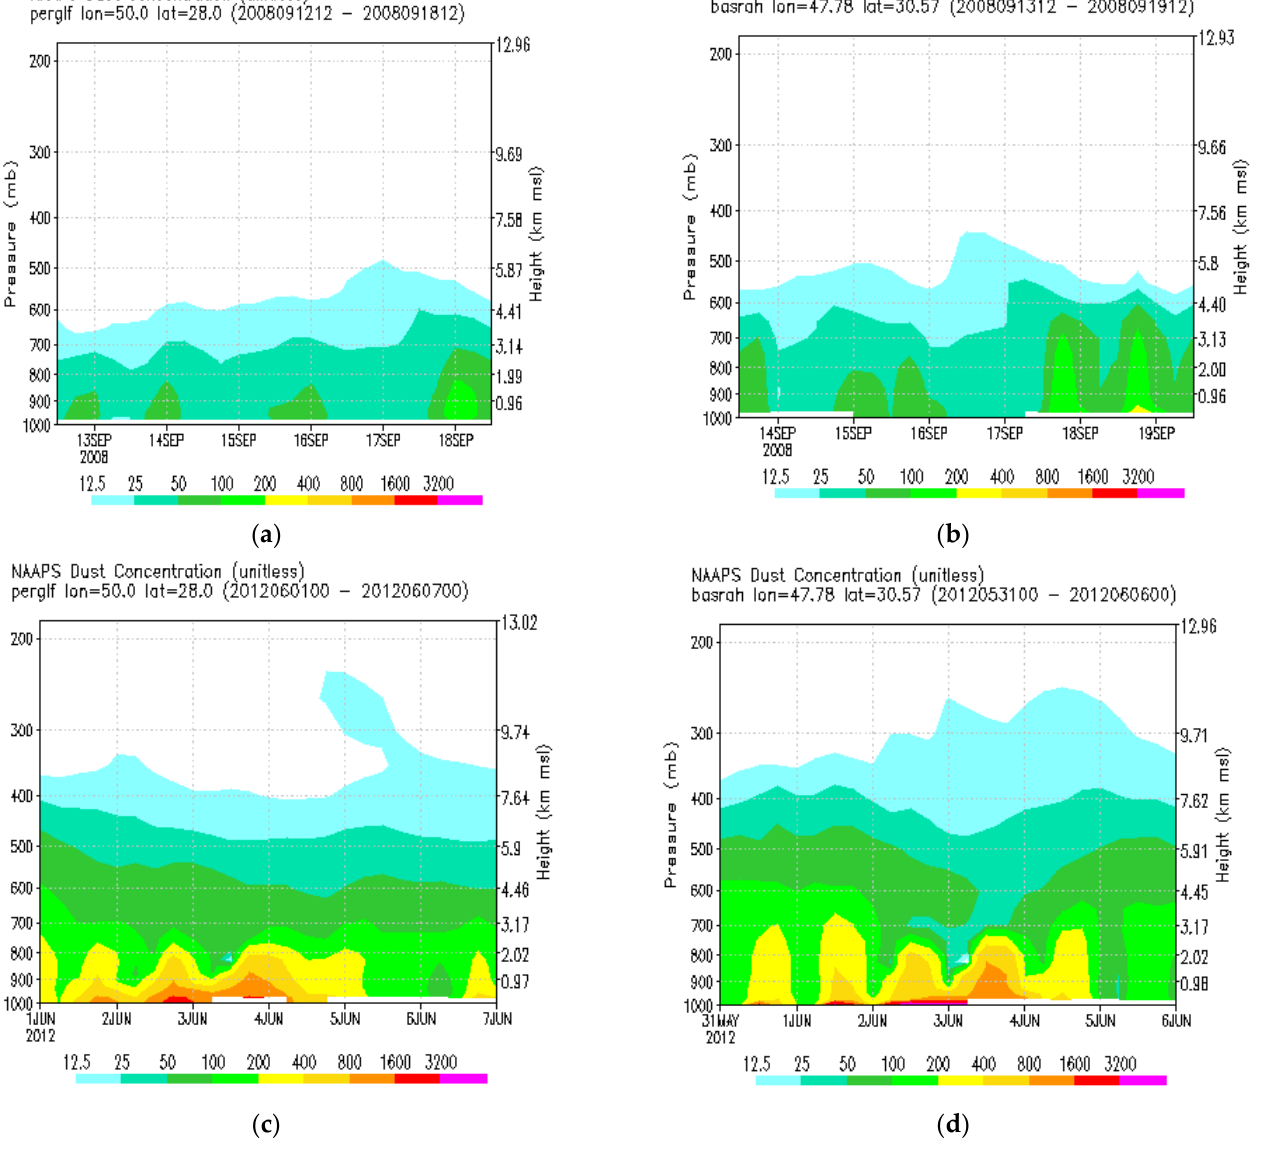
Figure 11. Vertical distribution of NAAPS output dust (μg m −3 ) in ( a , c ) the Persian Gulf and ( b , d ) Basra stations from 13 to 19 September 2008 and from 1 to 6 June 2012.